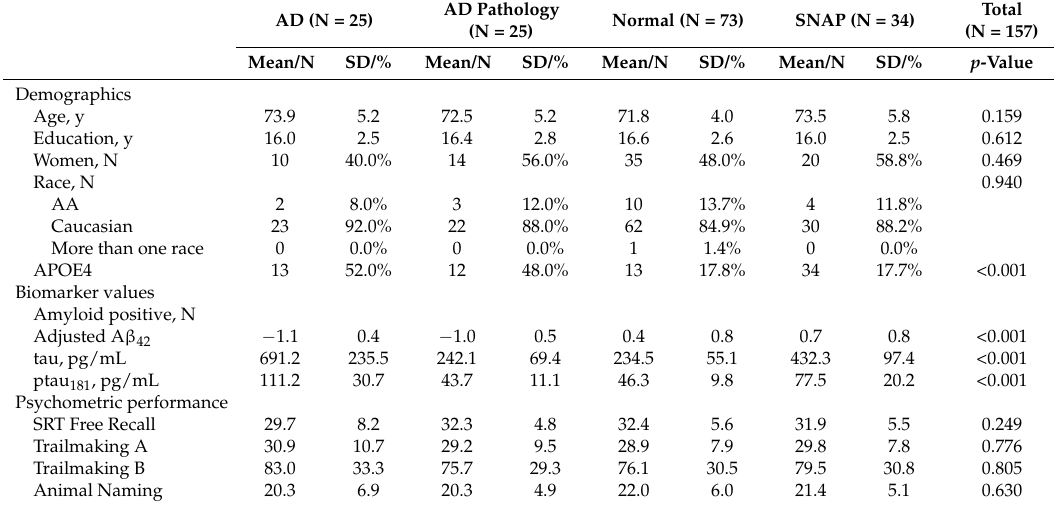
Table 1. Baseline demographic, biomarker and psychometric test performance for each group. AD Pathology AD (N = 25) Normal (N = (N = 25)